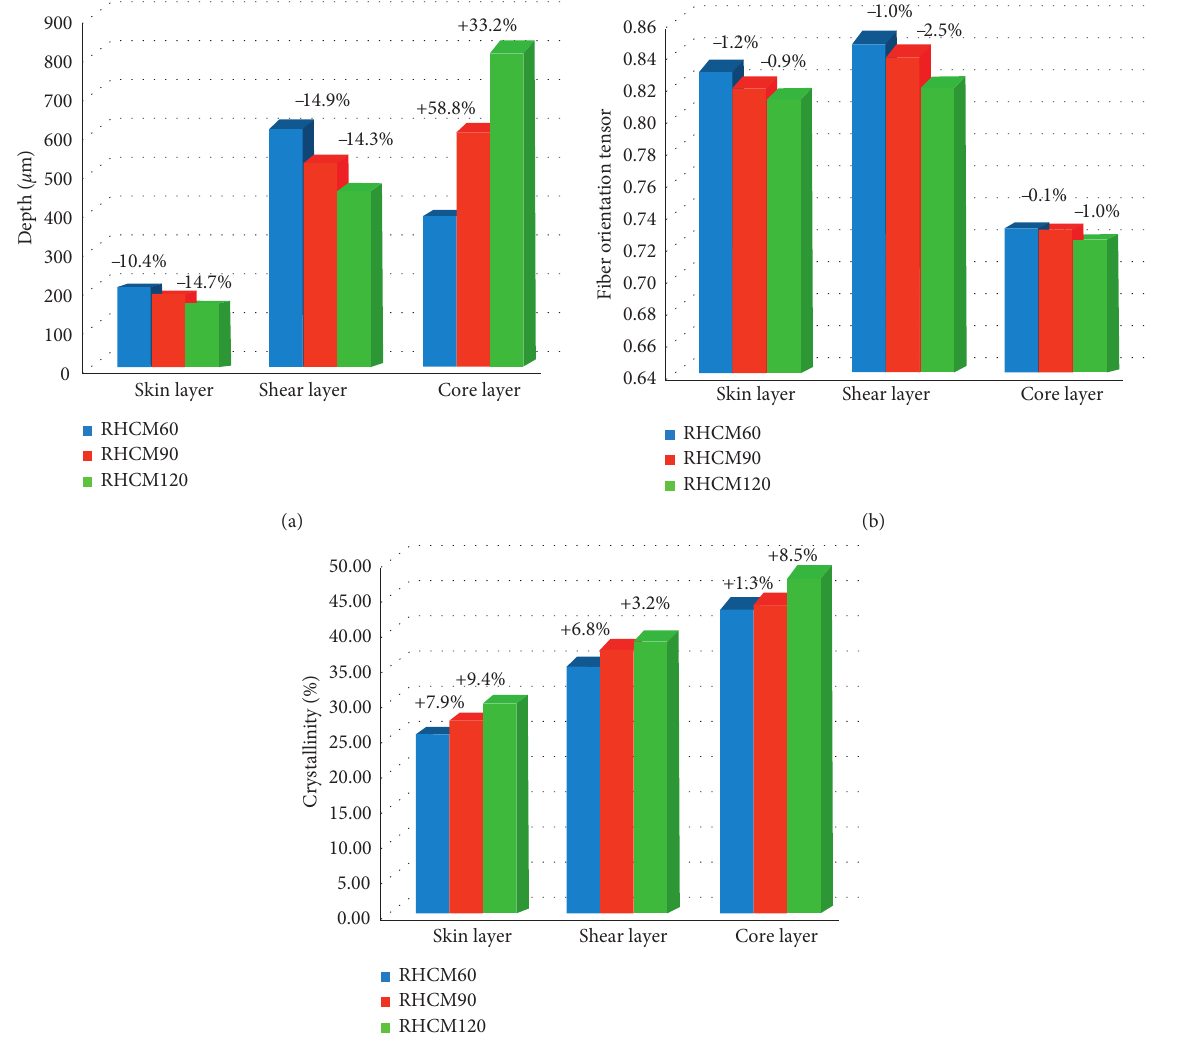
Figure 12: Comparison of microstructure layers in RHCM samples. (a) depth; (b) fiber orientation tensor; (c)